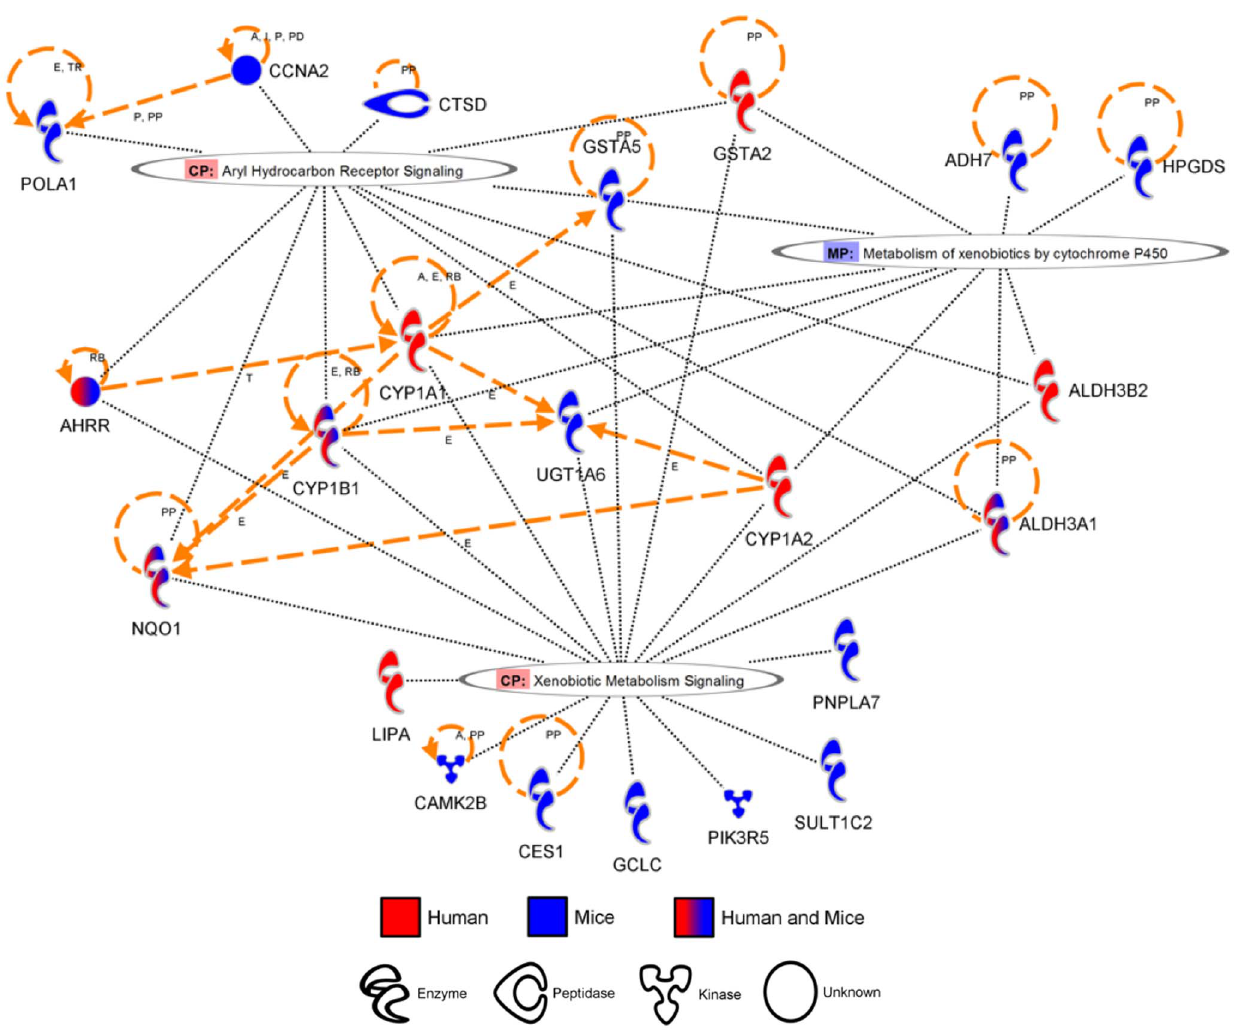
Figure 2. Genes associated to ‘‘Xenobiotics response/detoxification’’ pathways modulated by cigarette smoke exposure in humans and mice. Orthologue genes significantly upregulated in humans and/or mice (fold change . 2) were used to predict canonical pathways activated by cigarette smoke exposure. Diagram generated using the Ingenuity Pathway Analysis Software.